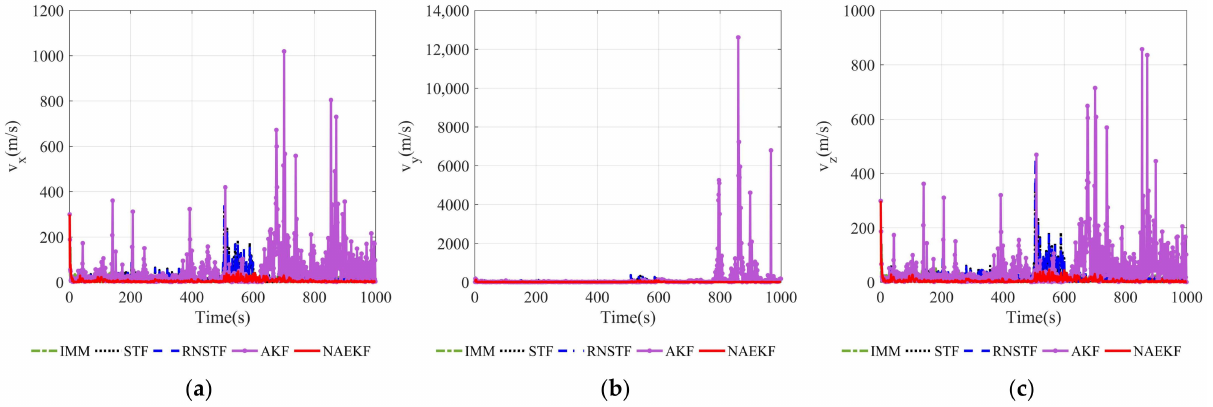
Figure 8. Velocity estimation errors. ( a ) Estimation errors of v x ; ( b ) Estimation errors of v y ; ( c ) Esti- mation errors of v z .